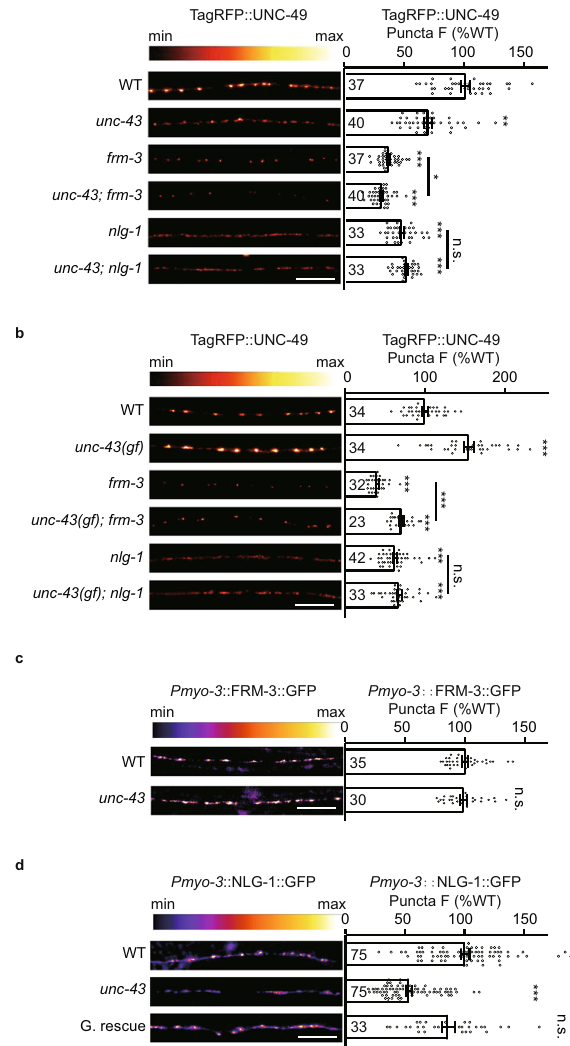
Fig.4|UNC-43/CaMKIIactsthroughasinglepathwaywithNLG-1/neuroliginto recruitGABA A Rs.a ThetagRFP-UNC-49puncta fl uorescenceintensitiesinthe unc- 43 ; nlg-1 double mutants were comparable to the nlg-1 single mutants. Repre- sentative images (left, scale bar 10 μ m, Pseudo-color: Red Hot) and mean puncta intensities+/ − SEM (right, Ns represent the number of animals tested) are shown. Kruskal – Wallis test with two-stage linear step-up procedure of Benjamini, Krieger, and Yekutieli correction for multiple comparisons. * p <0.05, ** p <0.01, *** p <0.001, n.s. not signi fi cant. b The tagRFP-UNC-49 puncta fl uorescence inten- sities in the unc-43 (gf) ; nlg-1 double mutants were comparable to the nlg-1 single mutants. Representative images (left, scale bar 10 μ m, Pseudo-color: Red Hot) and meanpunctaintensities+/ − SEM(right,Nsrepresentthenumberofanimalstested) are shown. One-wayANOVAwithtwo-stage linear step-up procedureof Benjamini, Krieger, and Yekutieli correction for multiple comparisons. *** p <0.001, n.s. not signi fi cant. c UNC-43 does not regulate postsynaptic FRM-3 localization. FRM-3- GFP fl uorescence intensities in the body-wall muscles in wild-type and unc-43 mutants were shown. Representative images (left, scale bar 10 μ m, Pseudo-color: Fire) and mean puncta intensities+/ − SEM (right, Ns represent the number of animals tested) are shown. Two-tailed and unpaired Student ’ s t -test. n.s. not sig- ni fi cant. d UNC-43 functions in the GABAergic neurons to stabilize postsynaptic NLG-1 localization. NLG-1-GFP fl uorescence intensities in the body-wall muscles in wild-type and unc-43 mutants were shown. Representative images (left, scale bar 10 μ m, Pseudo-color: Fire) and mean puncta intensities+/ − SEM (right, Ns repre- sent the number of animals tested) are shown. Kruskal – Wallis test with post-hoc Dunn ’ s test. *** p <0.001, n.s.notsigni fi cant. For a – d , source dataare providedasa Source Data fi